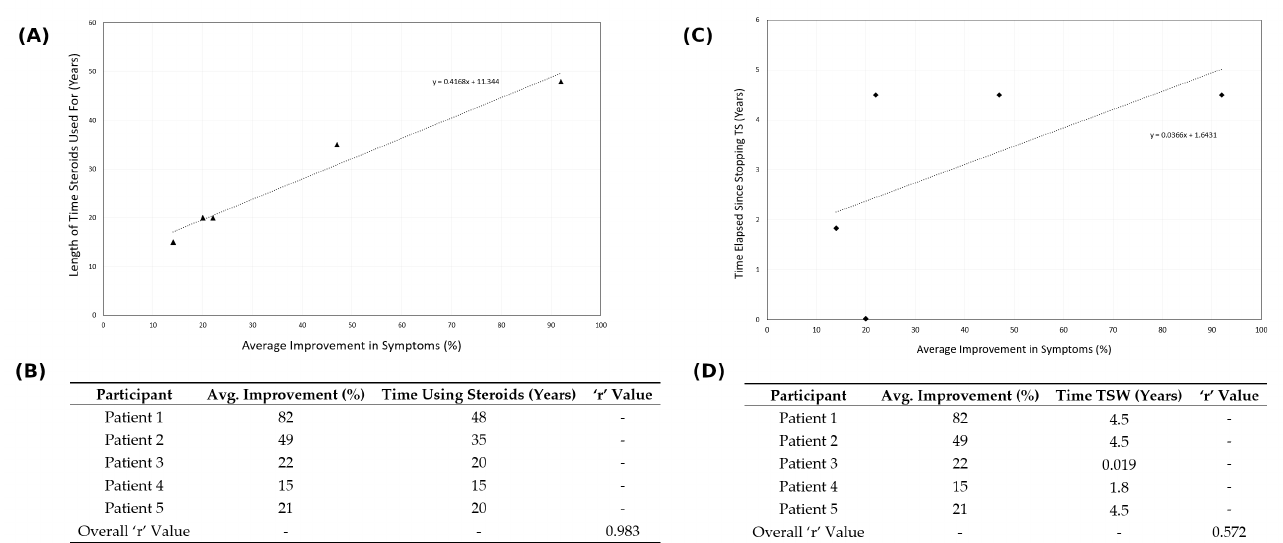
Figure 4. ( A ) Graph showing the length of time the participants used topical steroids for before quitting, against the average improvement in symptoms for the participants in this study ( r = 0.98). ( B ) Table showing the figures used to create the graph in ( A ), including the correlation coefficient between the two variables, ‘ r ’. ( C ) Graph showing length of time elapsed between stopping the use of topical steroids and starting the study against the average improvement in symptoms for the patients. ( D ) Table showing the numbers used to create the graph in ( C ), including the correlation coefficient, ‘ r ’, between the two